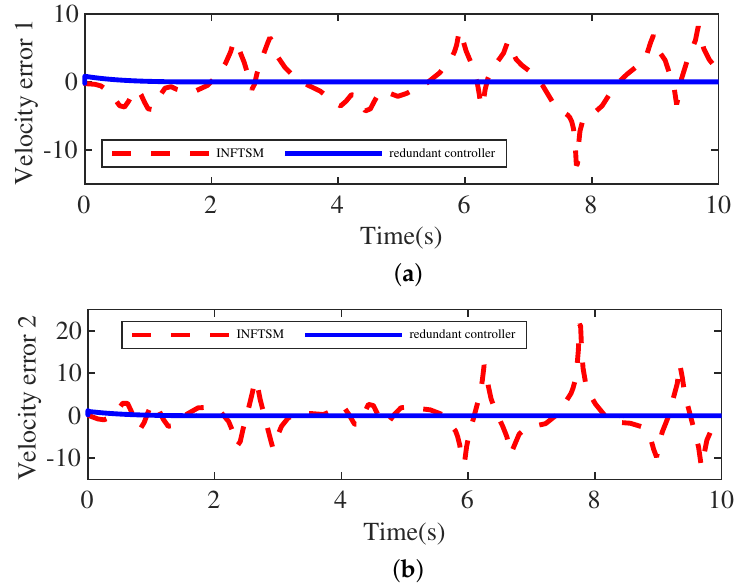
Figure 9. Comparison of velocity error when the system is in TLOE: ( a ) at joint 1 and ( b ) at joint